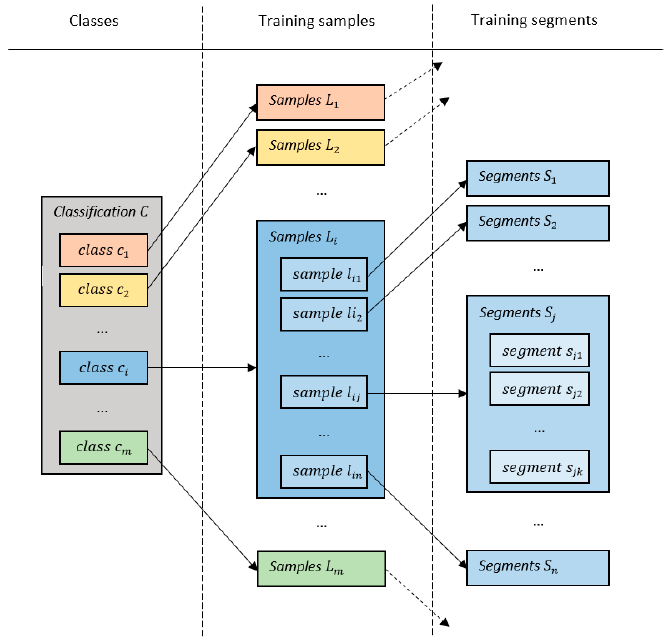
Figure 7. Class, sample and segment relations.